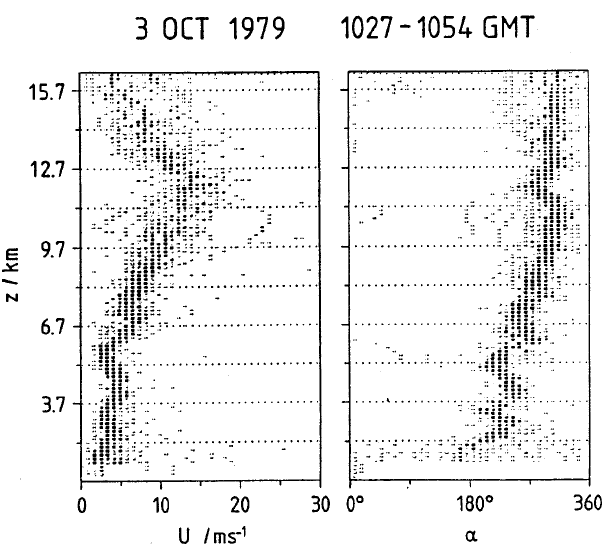
Fig. 2. Profiles of wind speed U and direction a measured with the SOUSY-VHF-Radar in the spaced antenna mode (after Ro¨ ttger and Czechowsky, 1981). Individual data points were obtained during an analysis period of 40 s. The scatter of these distributions results from natural variability of the wind, except at altitudes around 10–11 km and above 14 km, where the signal-to-noise ratio